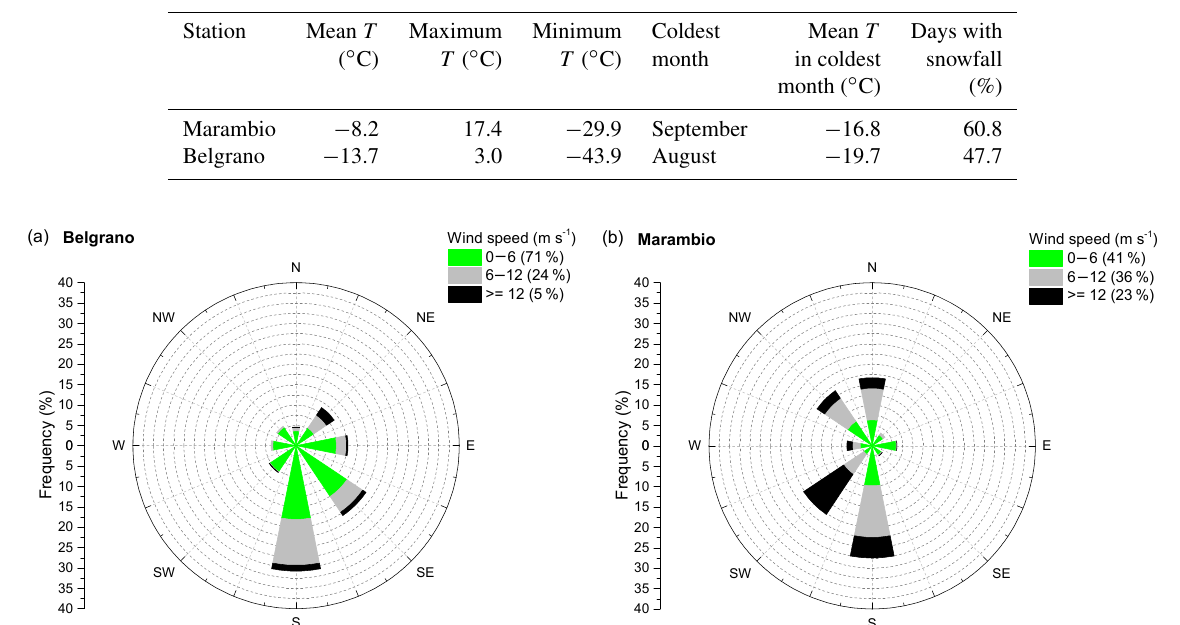
Figure 5. Wind rose at the Belgrano (a) and Marambio (b) stations (2015). The vertical scale indicates the frequency count. Belgrano data are gathered from INTA’s weather station and those at Marambio are provided by the WMO and the Argentinian Weather Service. The color code in both plots refers to different wind speed regimes: low wind conditions (<6ms − 1 , in green), medium wind conditions (6–12ms − 1 , in grey) and blowing snow conditions (>12ms − 1 , e.g., Jones et al., 2009, in black). The statistics of each regime at each station during 2015 are indicated in parentheses.